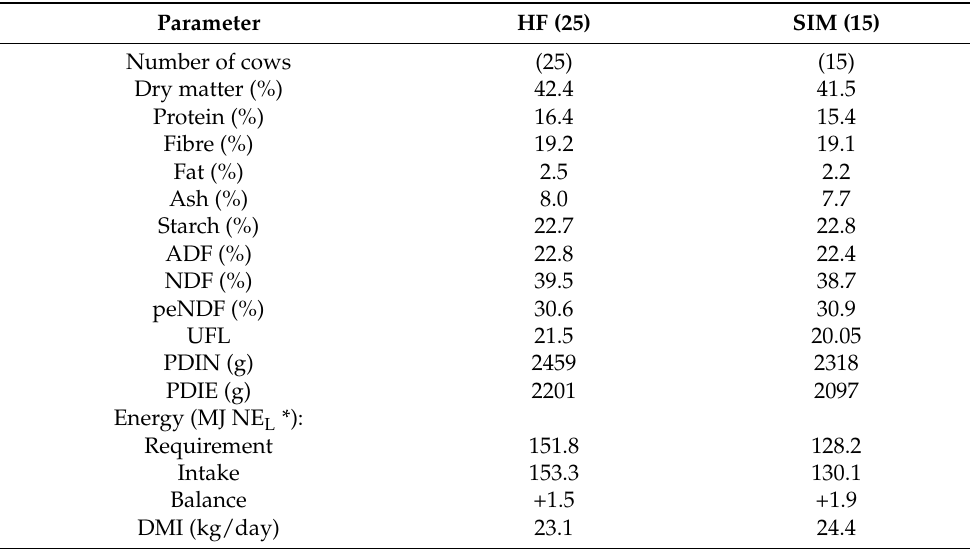
Table 4. Nutritional value and nutrient balance of the diet during early lactation in Holstein-Friesian (HF) and Simmental (SIM)